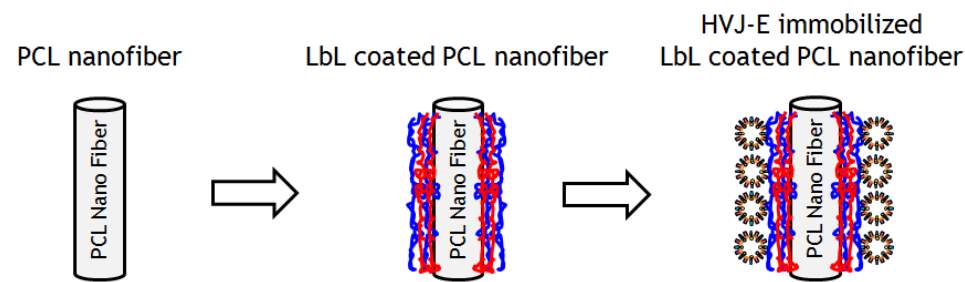
Figure 3. Cont. Figure 3. Cont.